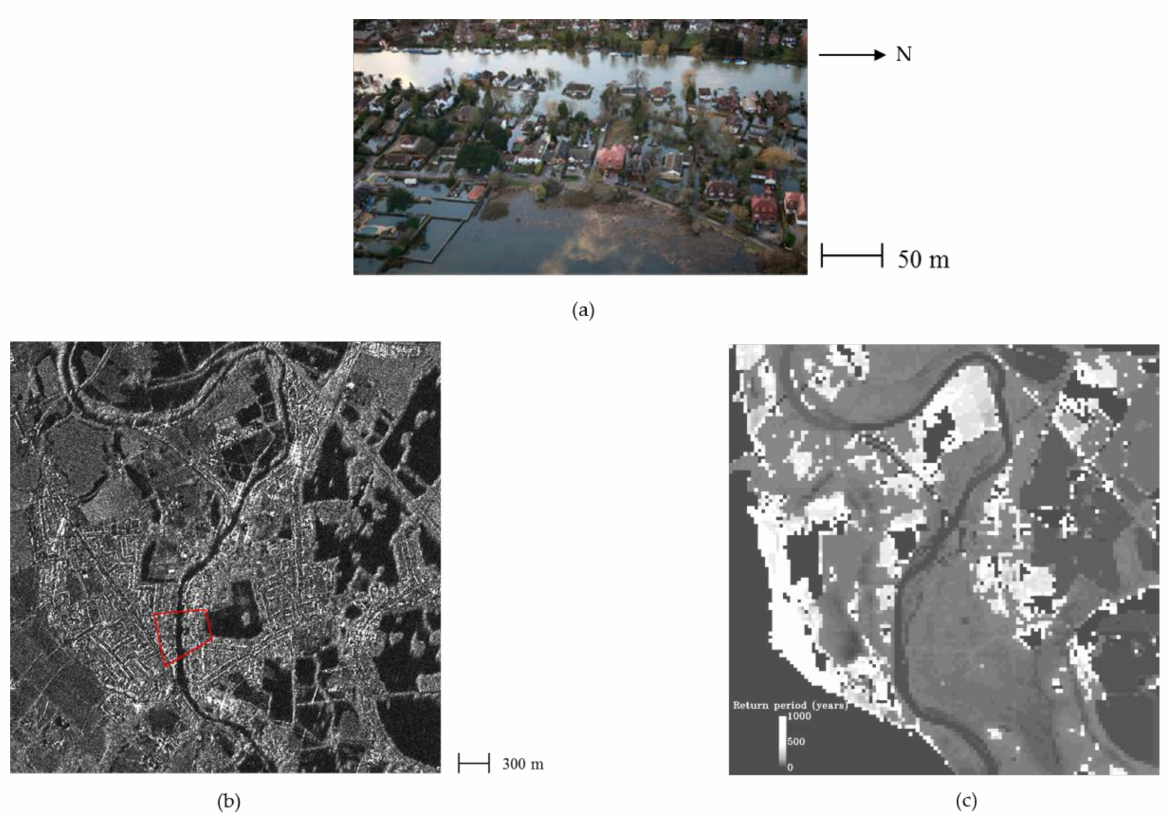
Figure 3. ( a ) Aerial photo of flooding in Wraysbury, West London (51.5 ◦ N, 0.6 ◦ W; about 300 × 300 m) (© Getty Images 2014) (after [38]), ( b ) CSK subimage (3 × 3 km) of Thames flood in Wraysbury, West London on 12 February 2014 (pixel intensities are digital number (DN) backscatter values; dark areas are water; red outline shows the area covered by aerial photo), and ( c ) flood return-period map (black areas masked